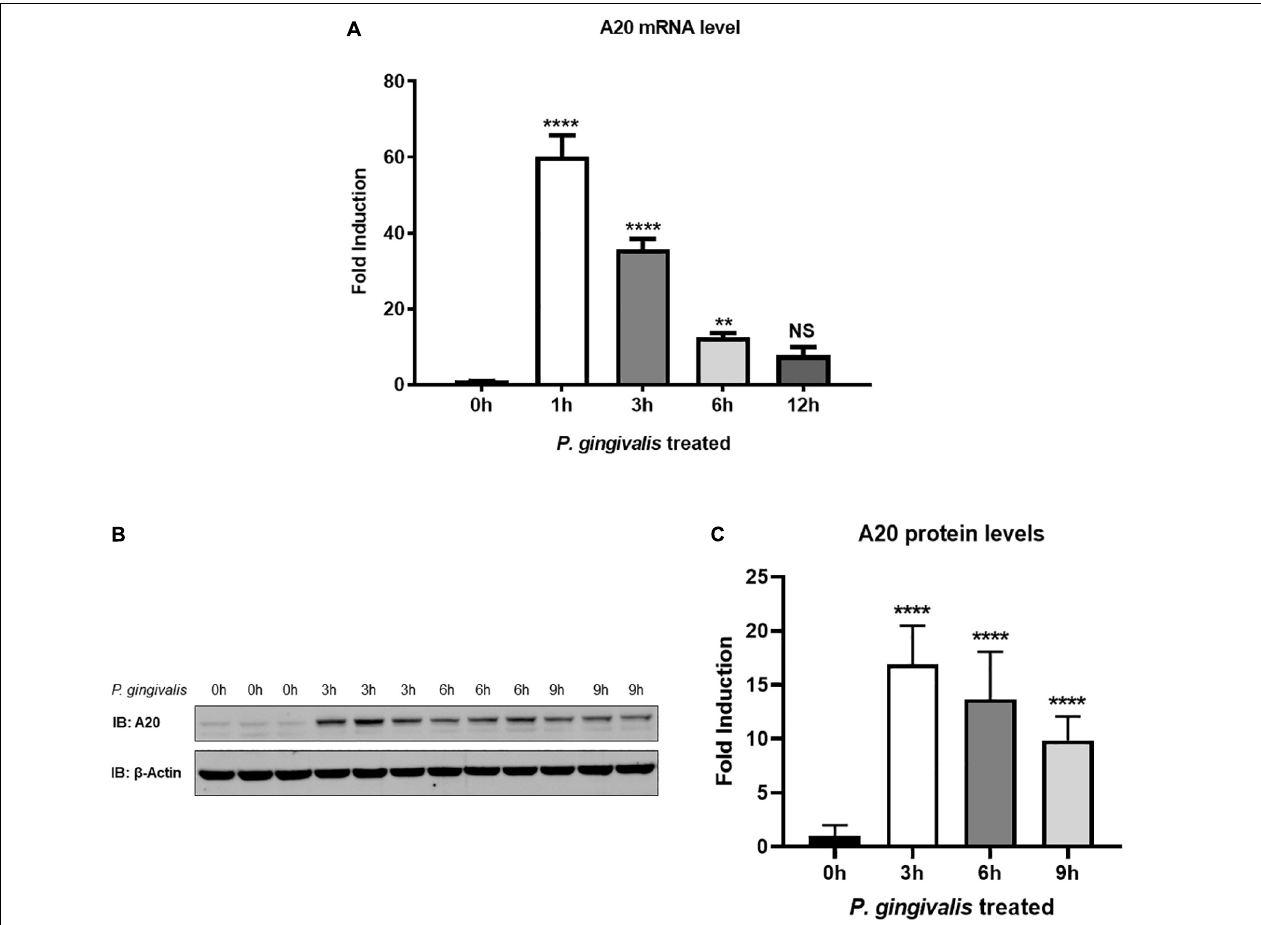
FIGURE 1 | A20 expression is induced by P. gingivalis infection in human gingival keratinocytes. (A) Quantitative polymerase chain reaction gene expression analysis of A20 expression in TIGKs after P. gingivalis (100 MOI) infection for indicated time. Each experiment was performed three times independently and representative blots were shown. NS, not significant, ** P ≤ 0.01, **** P ≤ 0.0001. Values are presented as mean ± SD. Representative blots (B) and corresponding quantification (C) show that the expression of A20 was induced by P. gingivalis . Values are presented as mean and standard